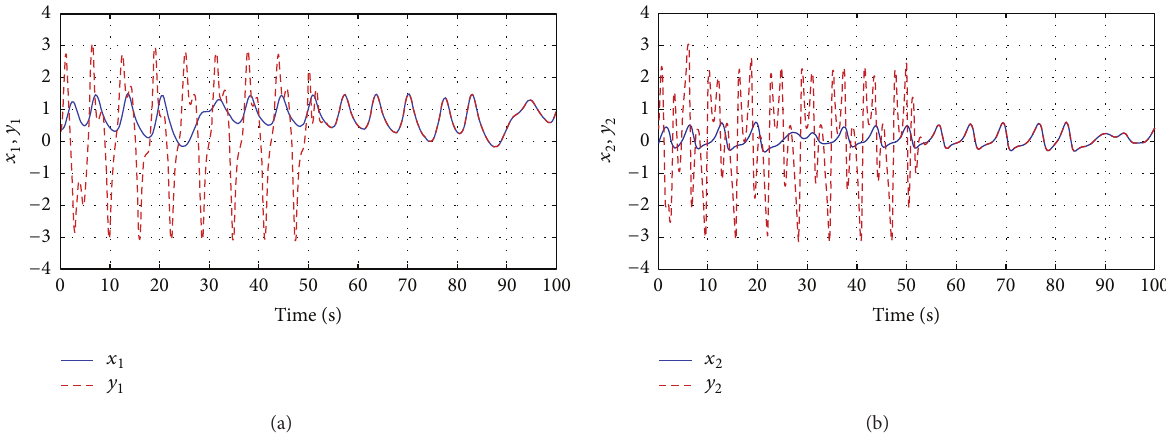
Figure 5: Time responses of chaos synchronization of coronary artery systems: master and slave system outputs are 𝑥 1 , 𝑥 2 (solid) and 𝑦 1 , 𝑦 2 (dashed), respectively. The control 𝑢(𝑡) is activated at 𝑡 = 50 sec.